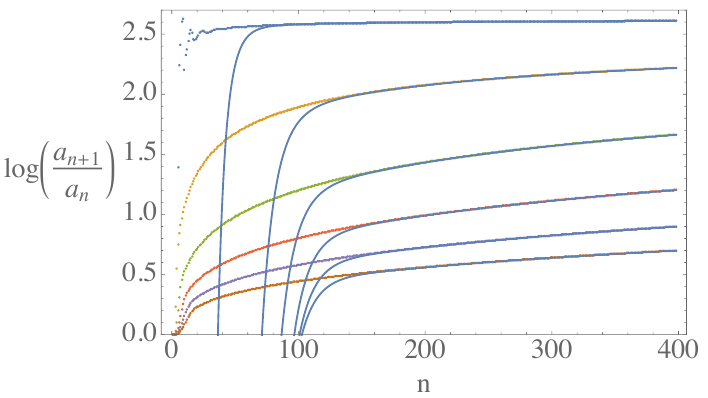
Figure 4 . This (cid:12)gure displays (cid:12)ts to logarithms of ratios of successive coe(cid:14)cients in the (cid:26) expansion of equation (6.1) up to the 400th order. In all cases we have set h = 0 identically, and the value of c increases from the top to the bottom of the plot, ranging from 1 : 5 to 10 5 . Each line corresponds to one of the points on (cid:12)gure 5, but for legibility we have only included every (cid:12)fth point.